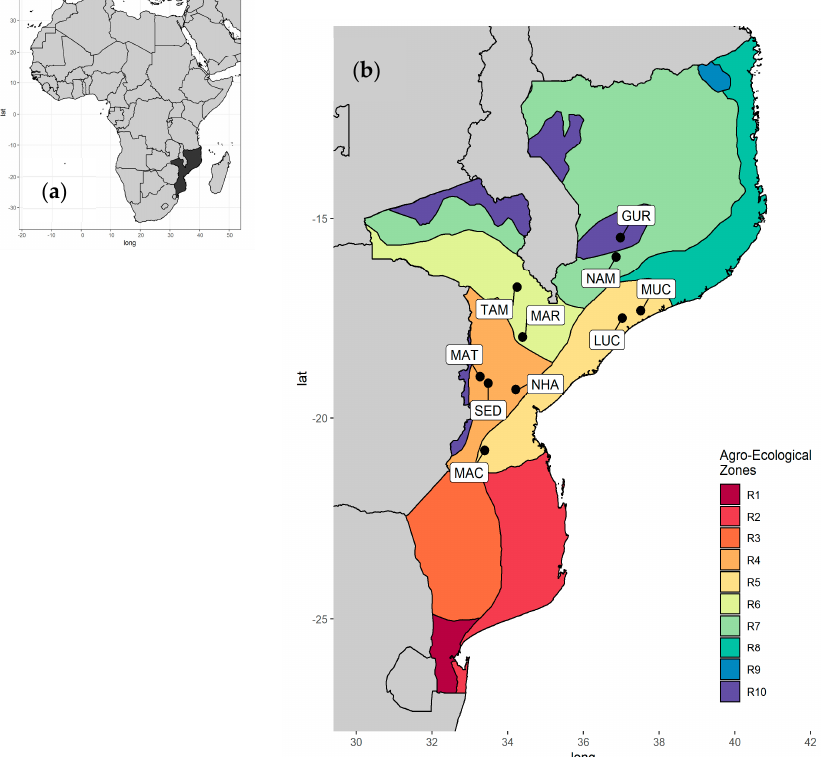
Figure 1. ( a ): Location of Mozambique in East Africa. ( b ): Dots indicate the studied landraces of Vigna unguiculata among the different eco-geographical zones (AEZs) existing in the country, based on [21]. Landraces code: Gurué (GUR), Namarroi (NAM), Muchela (MUC), Lucas Branco (LUC), Nhamatanda (NHA), Maringué (MAR), Tambara (TAM), Sede nova (SED), Matsinho (MAT), and Machaze (MAC).